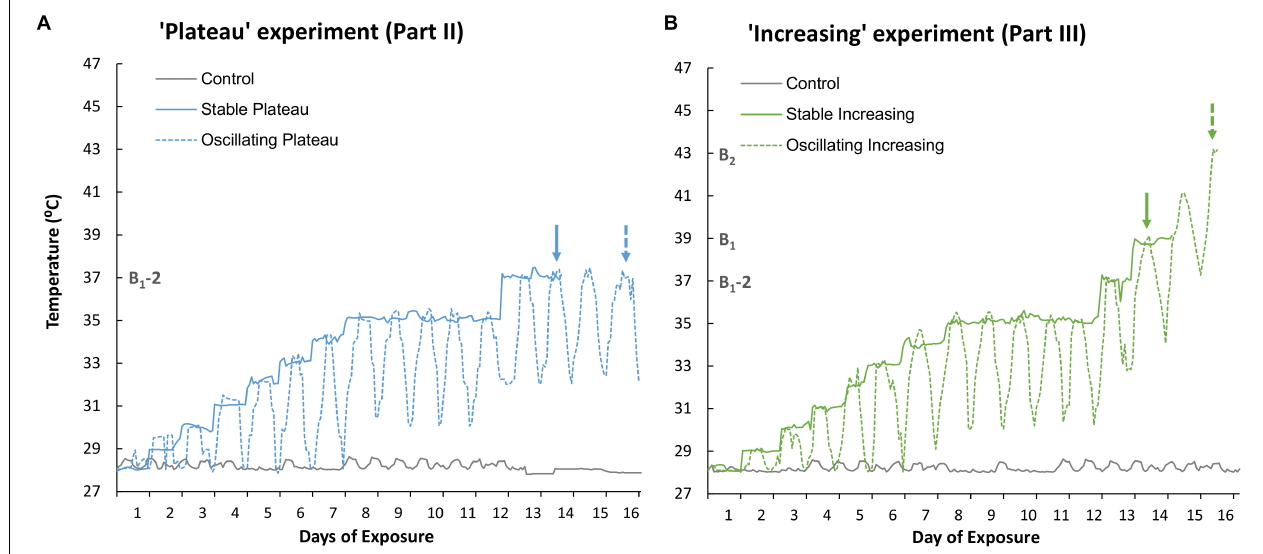
FIGURE 1 | Recorded temperature profiles of (A) the Stable Plateau [S Plat ] and Oscillating Plateau [O Plat ] treatments used in Part II of this study (the “Plateau” experiment) and (B) the Stable Increasing [S Incr ] and Oscillating Increasing [O Incr ] treatments employed in Part III of this study (the “Increasing” experiment). The recorded temperature profile of the control treatment is reported for Part II and Part III in panel (A) and (B) , respectively. Exposure days 8–12 mark the period of summer acclimation for the “Plateau” and “Increasing” experiments. The solid and dashed arrows represent when the “stable” and “oscillating” treatments bleached, respectively, in the “Plateau” experiment (blue arrows, Part II) and “Increasing” experiment (green arrows, Part III). B 1 and B 2 represent the temperatures ( ◦ C) at which treatments S Incr and O Incr bleached, respectively. B 1 -2 represents 2 ◦ C below the minimum bleaching temperature observed in the “increasing” treatments at which the “Plateau” treatments were held. Note; the “Plateau” experiment commenced 3 days later than the “Increasing” experiment to allow for the minimum bleaching temperature to be